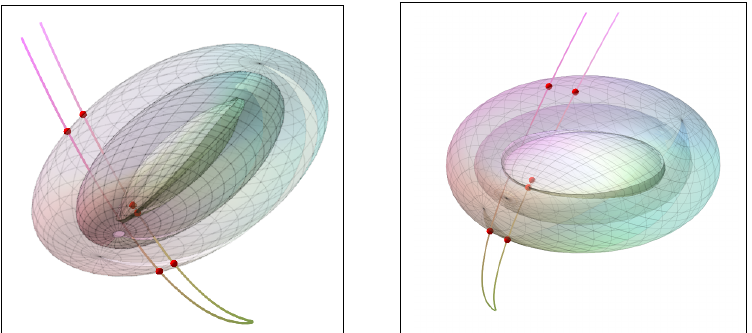
Figure 4. Intersection of an offset with a curve.